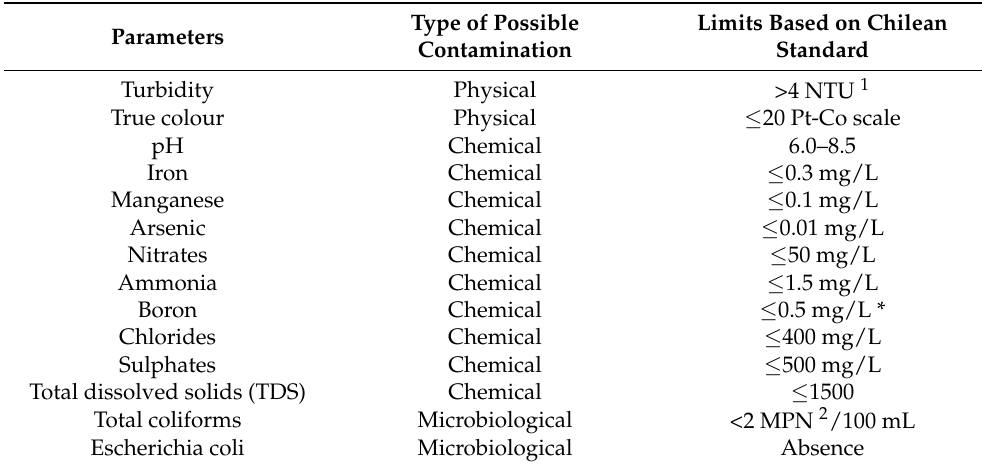
Table 2. Evaluated parameters in the six organizations. The list comprehends physical, chemical, and microbiological aspects based on prior State reports.